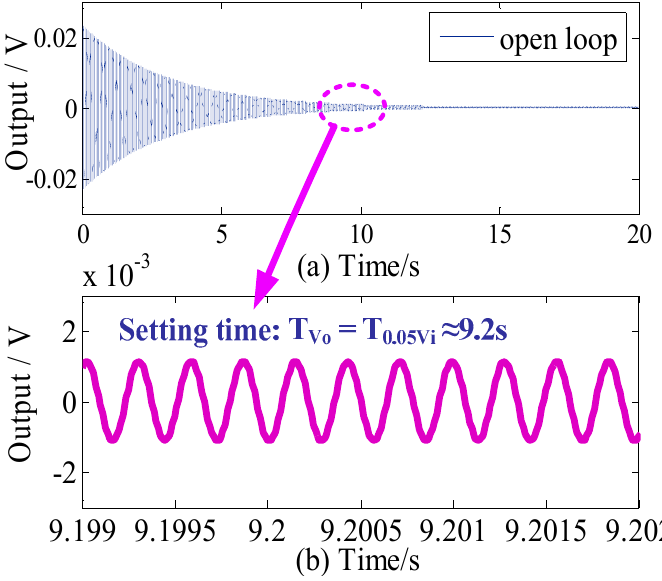
Figure 4. ( a ) Open-loop time-domain response of the sense mode and ( b ) enlarged view in 9.2 s.